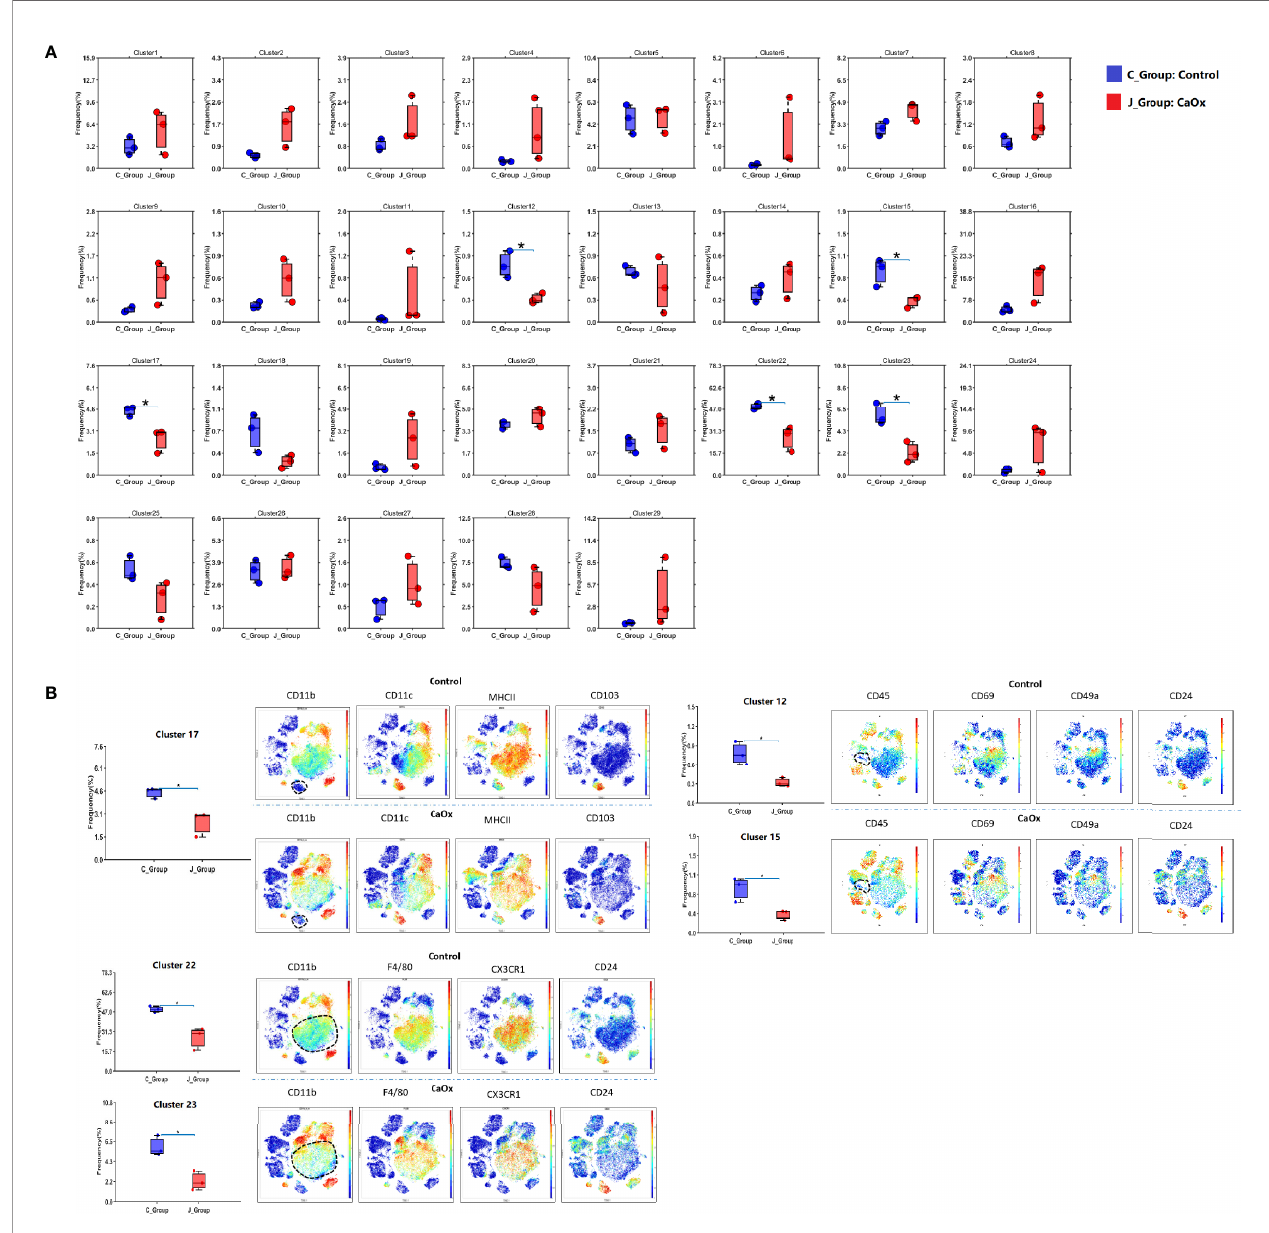
FIGURE 2 | Cluster frequencies in kidney of control mice and CaOx mice. (A) Frequencies of 29 clusters between groups. (B) Marker of signi fi cant differential clusters between groups. C_group stands for control group, and J_Group stands for CaOx group. Statistically signi fifi cant was shown as *p <